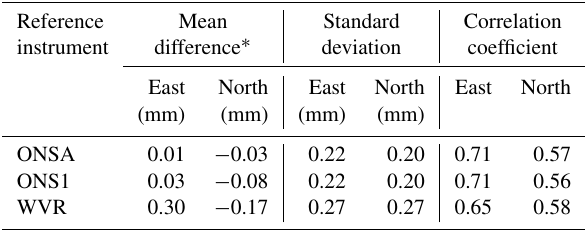
Table 11. Comparison of estimated wet gradients from VLBI rela- tive to GPS and WVR